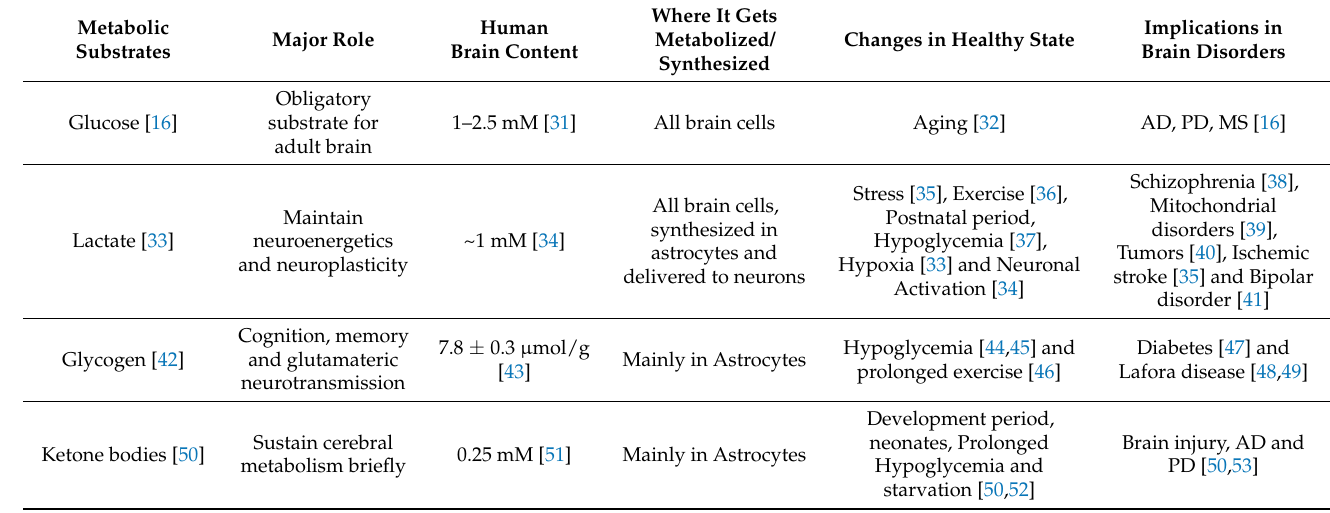
Table 2. Overview of relevant metabolic substrates for cerebral metabolism. AD—Alzheimer’s disease; PD—Parkinson’s disease; MS—Multiple